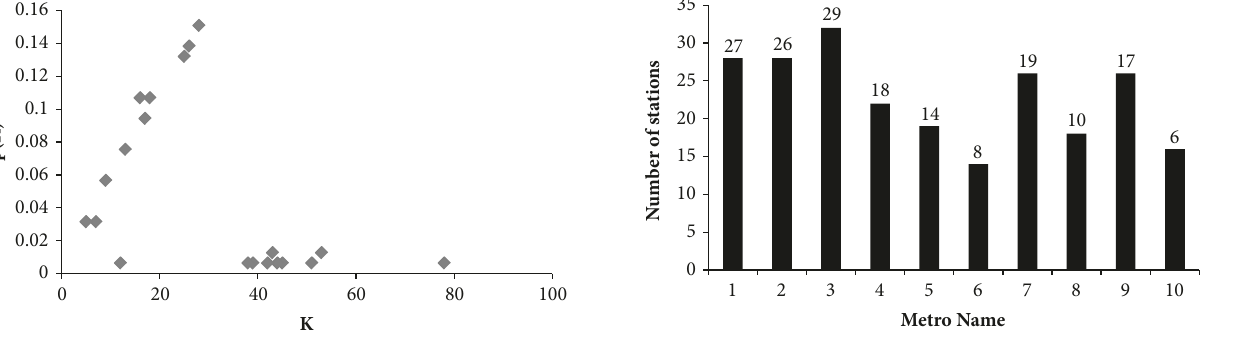
Figure 8: Distribution of hyperedge-node degree of hypernetwork in Nanjing